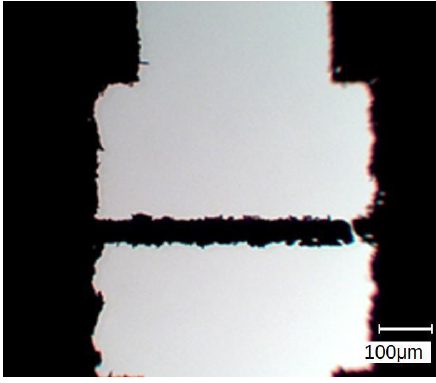
Figure 5. A 50 µm thick mask with a broken channel; magnification ×100.